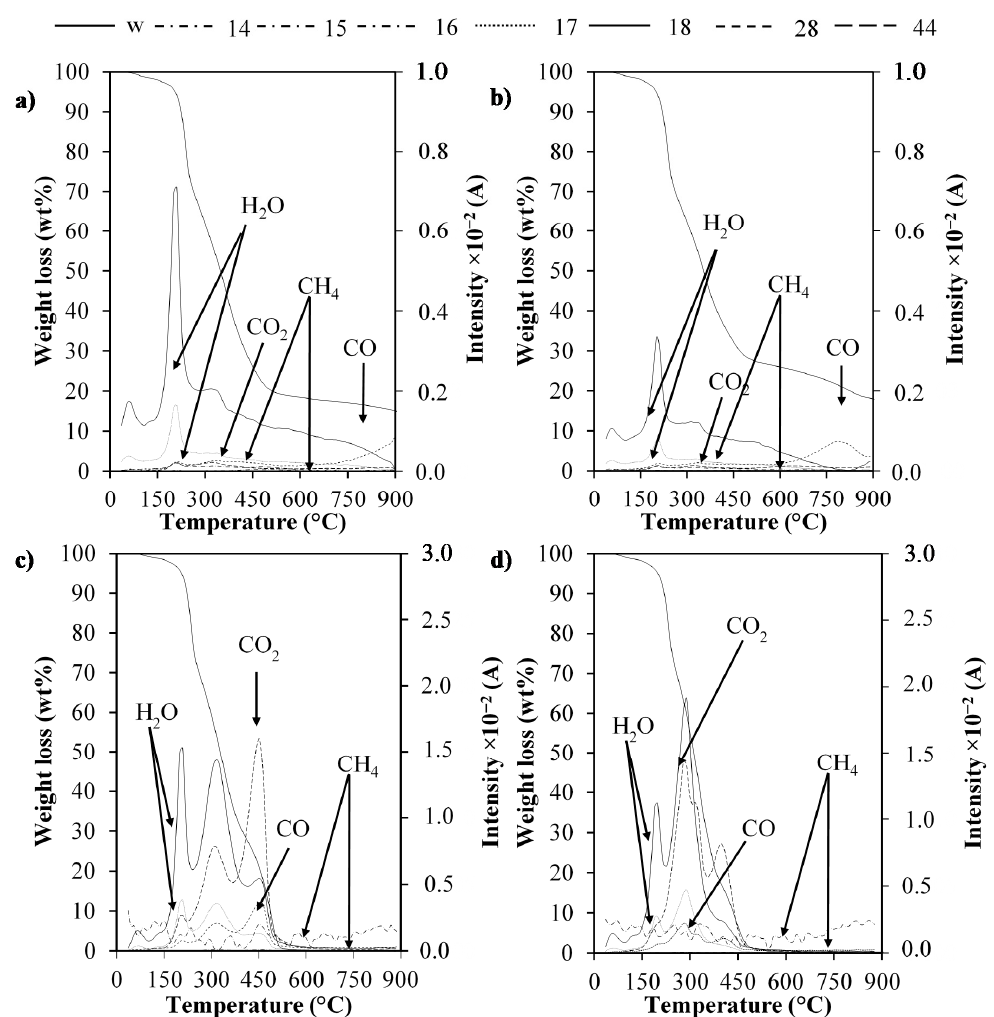
Figure 5. Profiles of the ions m/z = 14, 15, 16, 17, 18, 28 and 44 by TG-MS at 30 °C min − 1 , during ( a , b ) pyrolysis and ( c , d ) combustion, for ( a , c ) biomass y ( b , d ) biomass/catalyst 1:1. Catalyst: Rh-Pt/CeO 2 - pyrolysisand( c , d )combustion, for( a , c )biomassy( b , d )biomass / catalyst1:1. Catalyst: Rh-Pt / CeO 2 -SiO 2 SiO 2 .